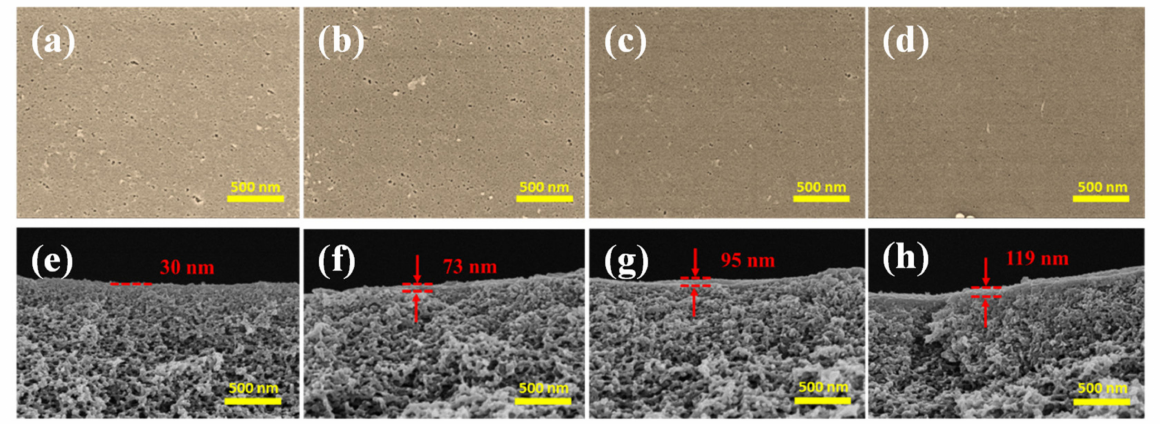
Figure 5. The surface ( a – d ) and cross section morphology ( e – h ) of PES/Fe-TA membranes with different TA assembly times.